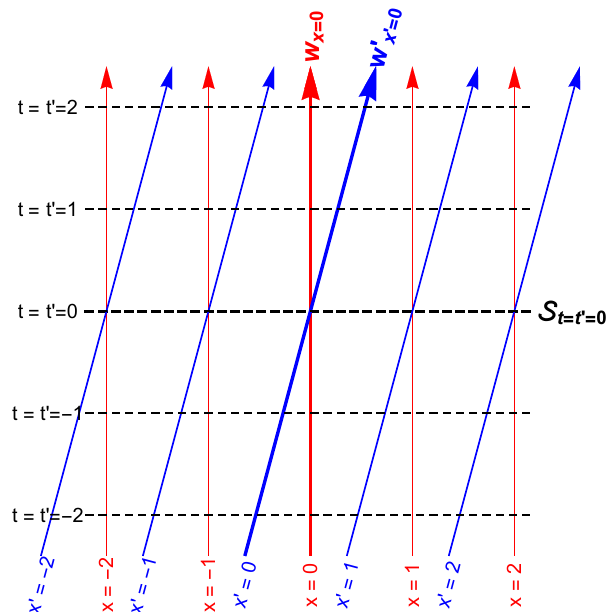
Figure 3. Galilei/Newton spacetime G as charted in time coordinate t and position space coordinate x (other position space dimensions suppressed) by a global inertial frame (cid:79) (observer worldlines, red; surfaces of simultaneity, black). A second inertial frame (cid:79) (cid:48) (observer worldlines, blue; surfaces of simultaneity, black) with coordinates t (cid:48) , x (cid:48) moving with positive velocity in the x direction relative to (cid:79) is also shown. In accordance with the absolute nature of time in Galilei/Newton spacetime, the surfaces of simultaneity of (cid:79) and (cid:79) (cid:48)